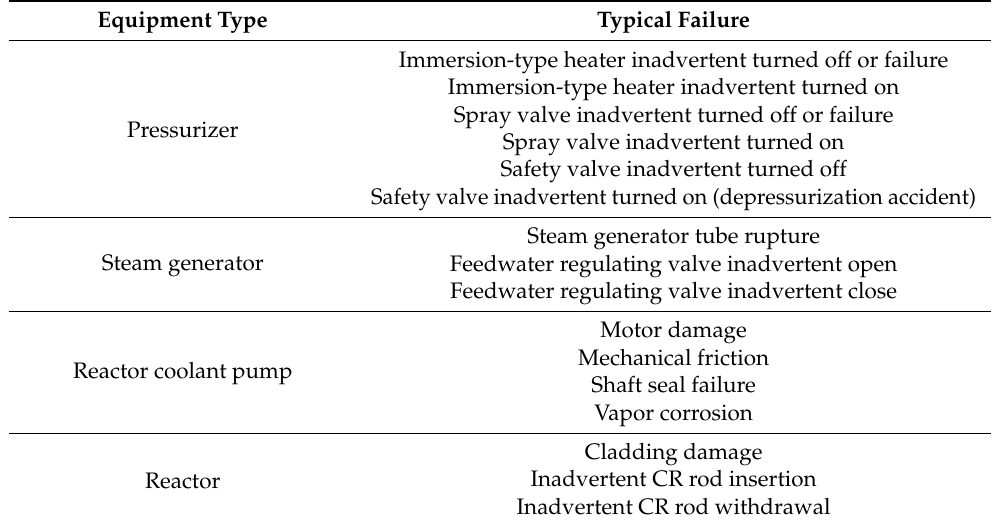
Table 5. Typical faults of the reactor coolant system’s